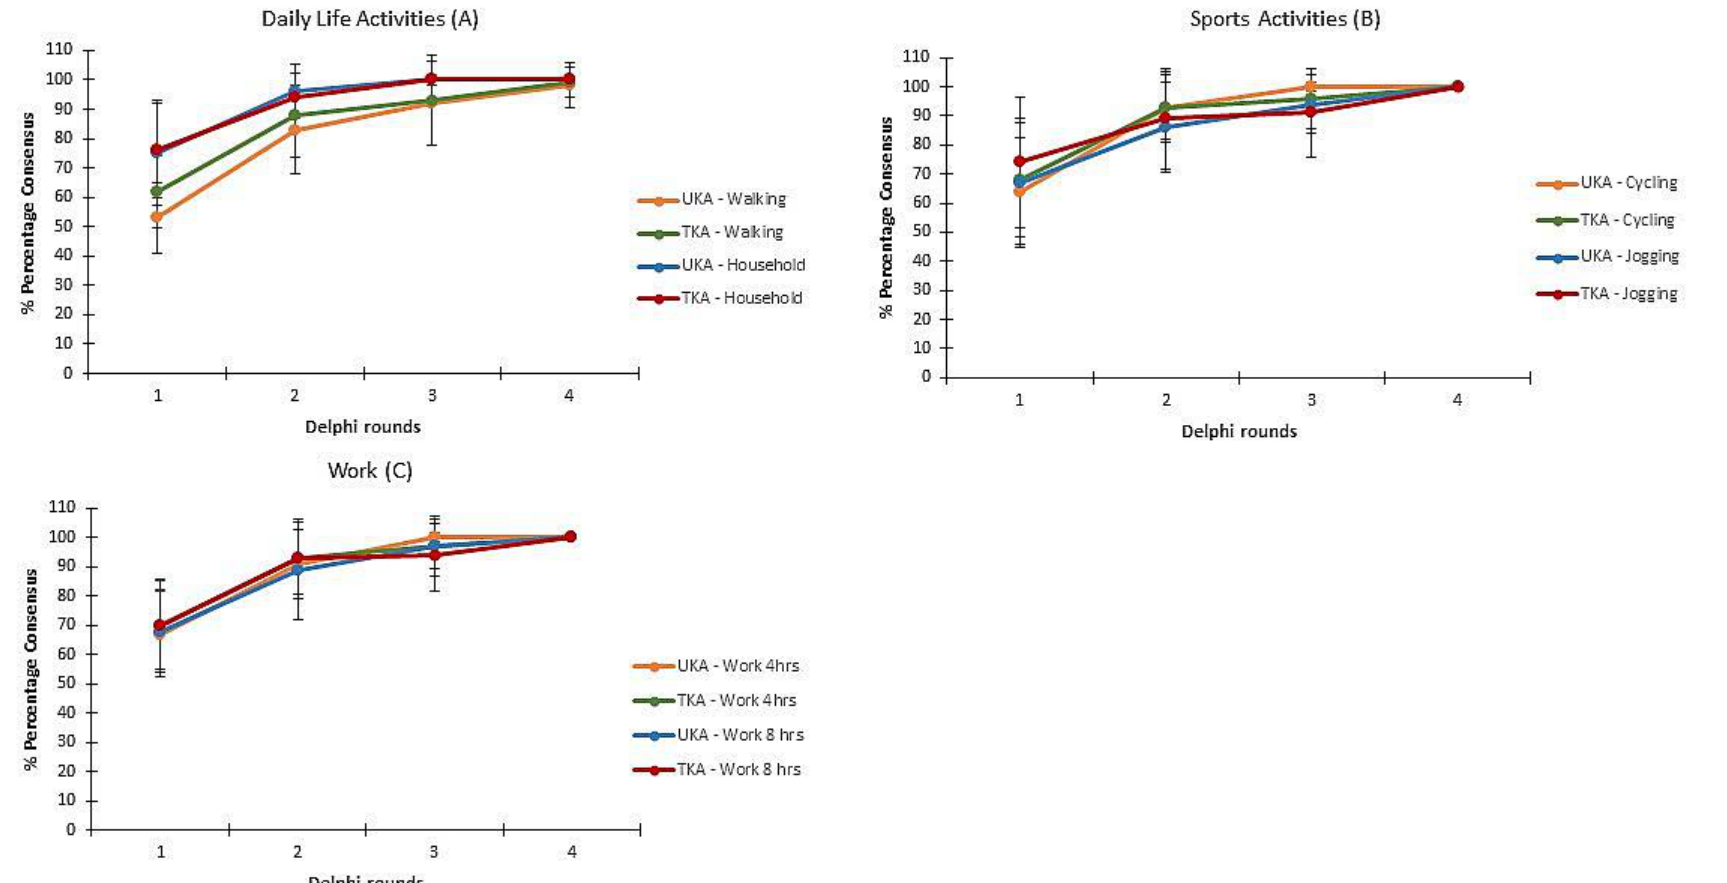
Figure 3. Mean percentage of consensus per Delphi round for patients with an average recovery rate for three categories of activities: daily life ( A ), sports ( B ) and work ( C ). The error bars represent the standard